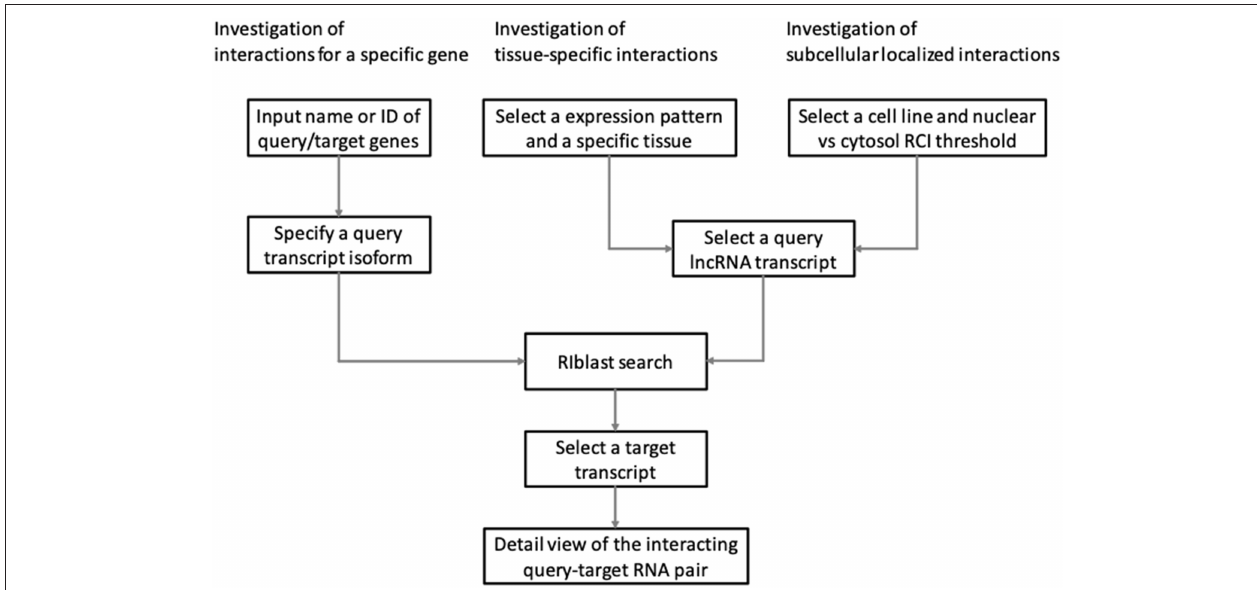
FIGURE 1 | Three workflows for investigating lncRNA–RNA interaction using LncRRIsearch.